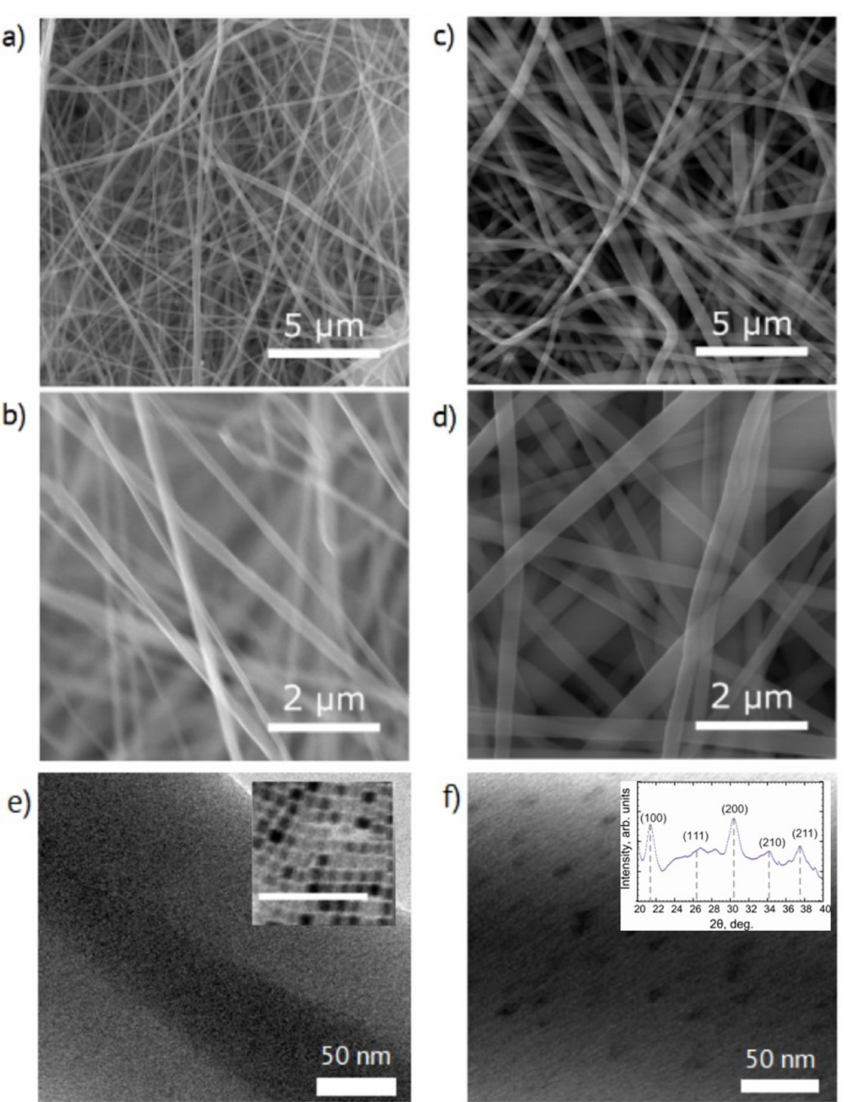
Figure 2. ( a , b ) SEM, and ( e ) TEM images of the electrospun mats without perovskite nanoparticles (NPs) and ( c – f ) with NPs. Inset in ( e ) demonstrate TEM image of as-synthesized NPs, the scale bar is 100 nm. Inset in ( f ) shows X-ray powder diffraction pattern of CsPbBr 3 NPs in nonwoven fibers. Despite the vanishingly small mass fraction of perovskite NPs in fibers and the strong